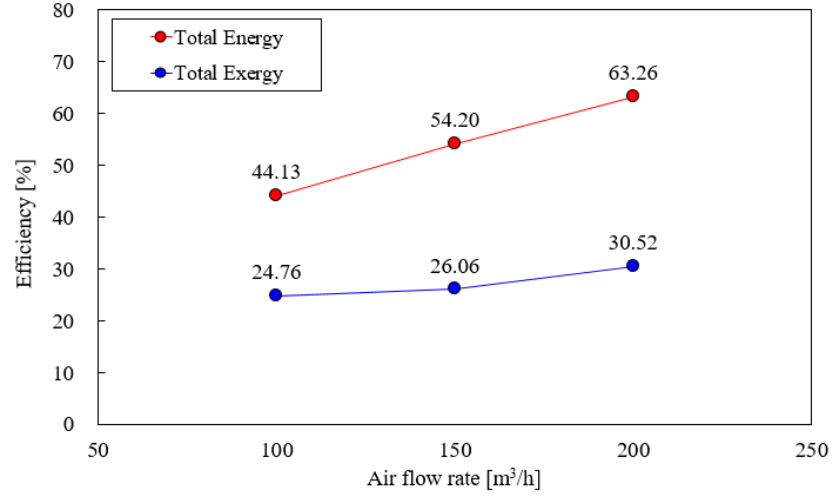
Figure 10. Compare with energy efficiency and exergy